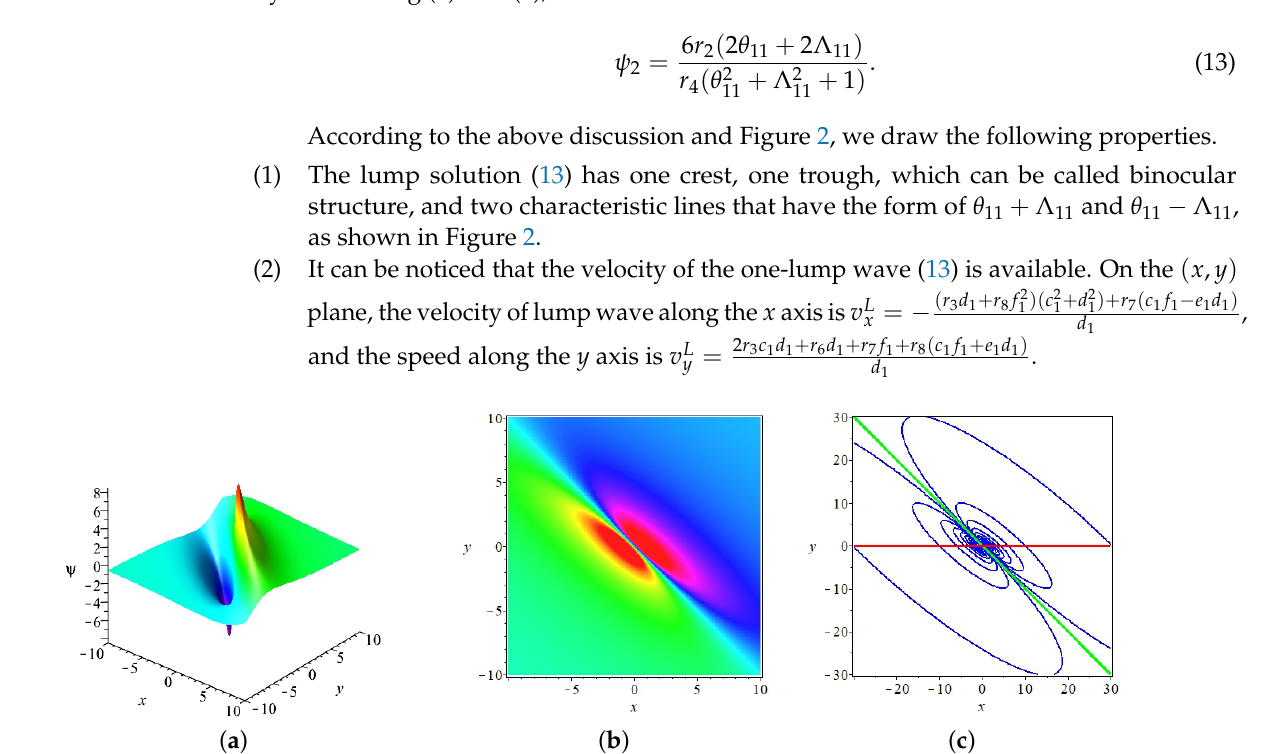
Figure 2. (Color online) One-lump Solution (13) with r 2 = r 3 = r 4 = r 6 = r 7 = r 8 = 1, a 1 = 0, b 1 = 0, corresponding contour figure. ( c ) Characteristic lines figure, the red line ( y = 0) and the green line ( x + y = 0) are two characteristic lines of the one-lump